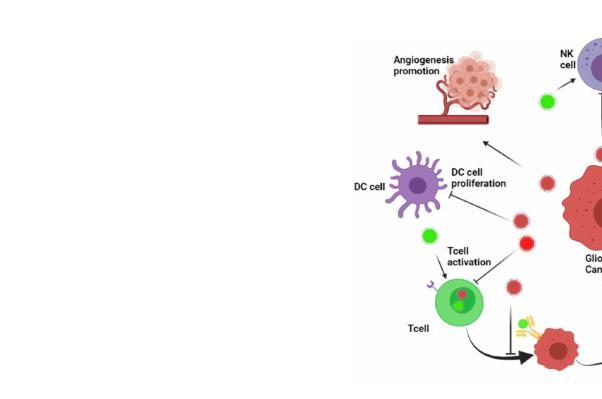
FIGURE 2 | The roles of exosomes in glioma ’ s development. The role of exosomes in cancer progression. Cancer cell – derived exosomes in fl uence the formation of the pre-metastatic microenvironment, tumor growth and advancement, immune escape, angiogenesis promotion, stopping of apoptosis, drug resistance, and